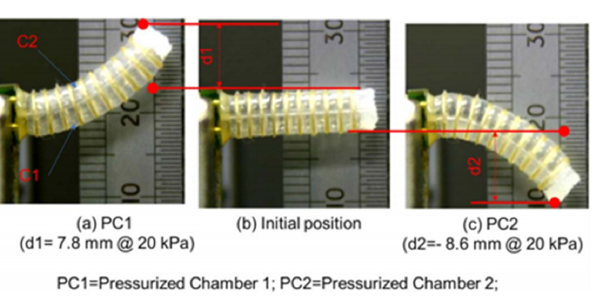
Figure 12. Example of ECF actuator at different pressures [77]. (Open Access). Table 3. Summary comparing different soft robotic technologies.